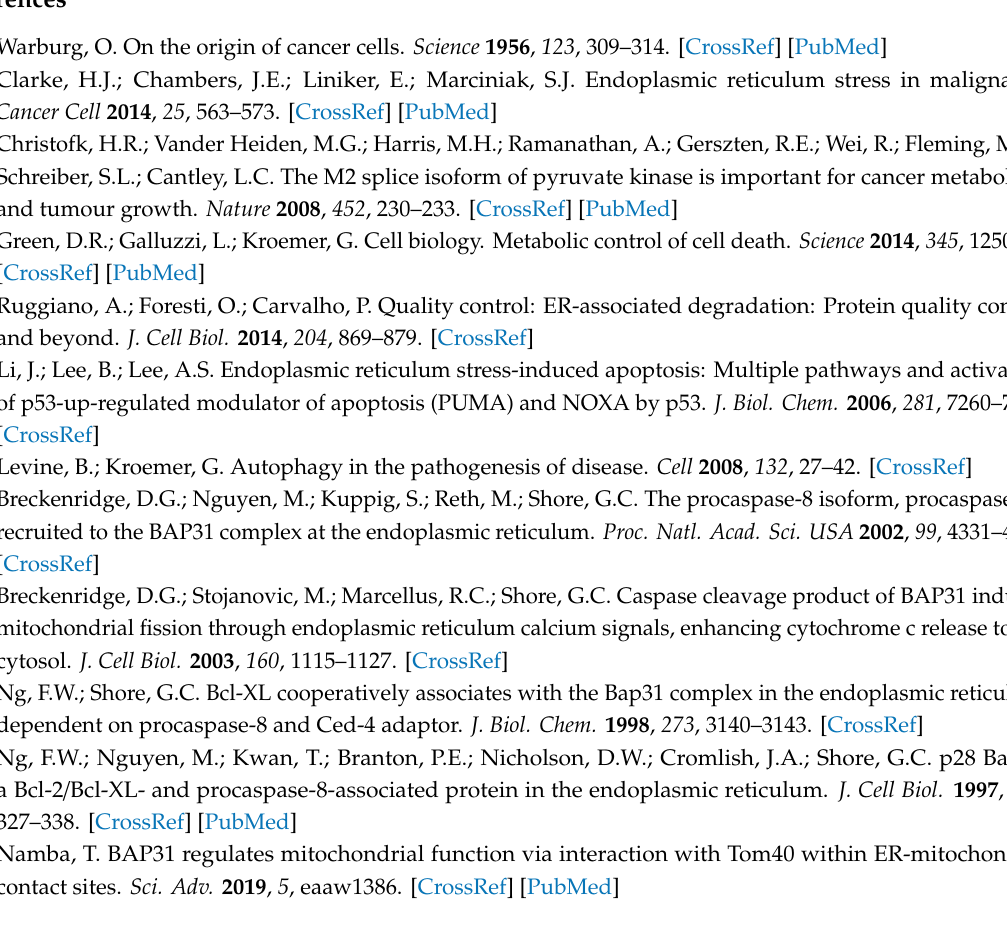
Figure S1: The quantification analysis for Figure 1a,b. Figure S2: ER stress induced autophagy and cell death is suppressed by knockdown of ATG7. Figure S3: The overexpression of BAP31 suppresses ER stress-induced autophagy. Figure S4: The suppression of BAP31 reduces p62 expression levels. Figure S5: The loss of BAP31-suppressed ER stress-induced apoptosis by inducing autophagy. Figure S6: BAP31 interacts with STX17 in human normal fibroblast cells. Figure S7: BAP31 interacts with STX17 on the ER and ER-mitochondria contact sites in U2OS cells. Figure S8: BAP31 knockdown stimulates starvation induced STX17 and ATG14 interaction in U2OS